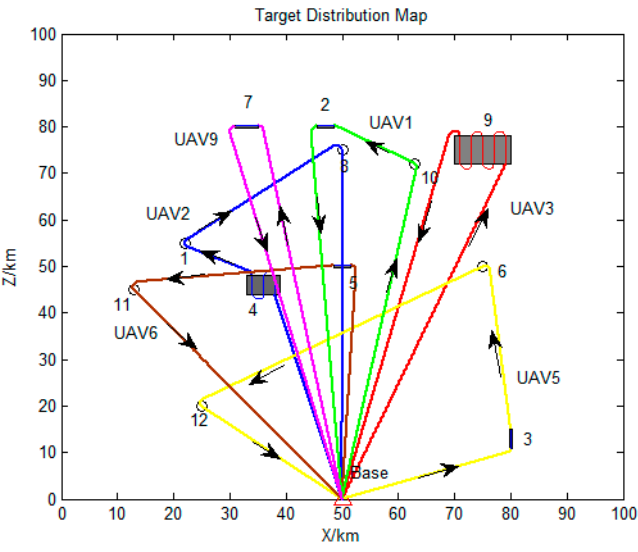
Figure 14. Paths of employed UAVs.